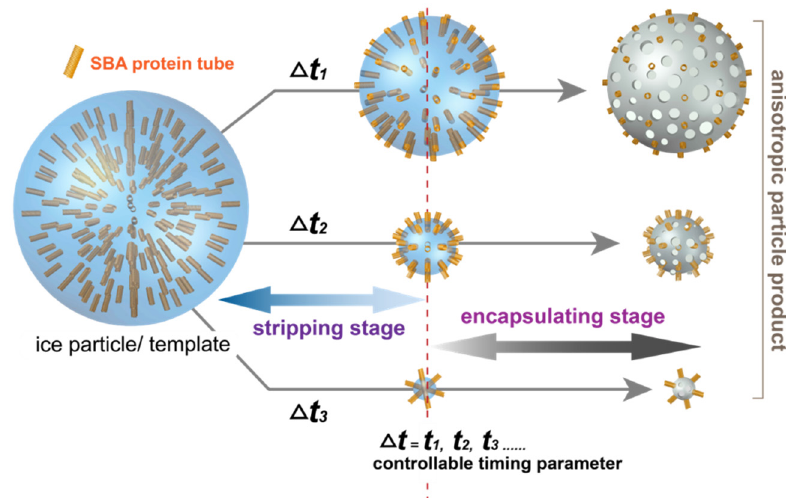
Figure 1. Illustration of the CVSD fabrication process to construct anisotropic nanomaterials. A time-dependent ( Δ t ) control parameter was used to control both the stripping stage and encapsulating stage during CVSD to tune the final hybrid products with a determined size and dimensional configuration.